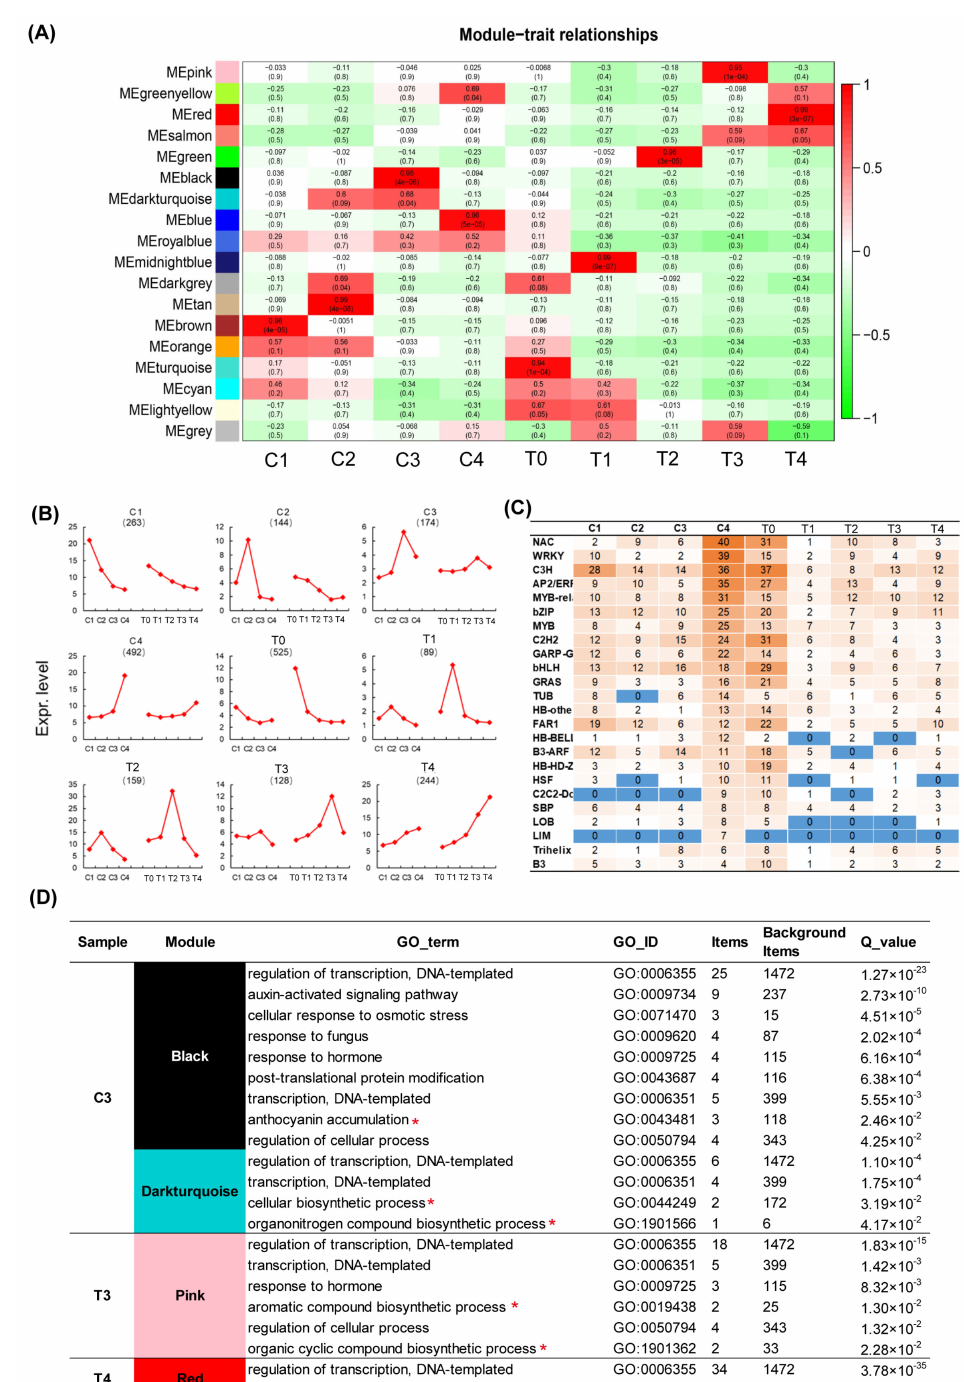
Figure 6. Analysis of transcription factor genes in the tepal and corona of narcissus. ( A ). Analysis of WGCNA of 3,193 transcription factor family genes. Module-sample correlations and corresponding p -values (in parenthesis). The left panel shows the sixteen modules. The color scale on the right shows module-trait correlation from − 1 (green) to 1 (red). ( B ). Gene expression patterns within different sample-specific modules. Y axis represents the average expression value of genes in sample-specific modules, and the numbers in parentheses represent the number of genes in sample-specific modules. ( C ) . Distribution of transcription factor families in the tepal and corona during flower development. ( D ) . Functional GO enrichment analysis of the transcription factor specific module of C3, T3 and T4 refered to Figure 6A; red star labeled indicates floral pigment and fragrance metabolism related pathway. Black and darkturquoise modules are the specific modules of C3, pink is T3 sample-specific module and red is T4 sample-specific